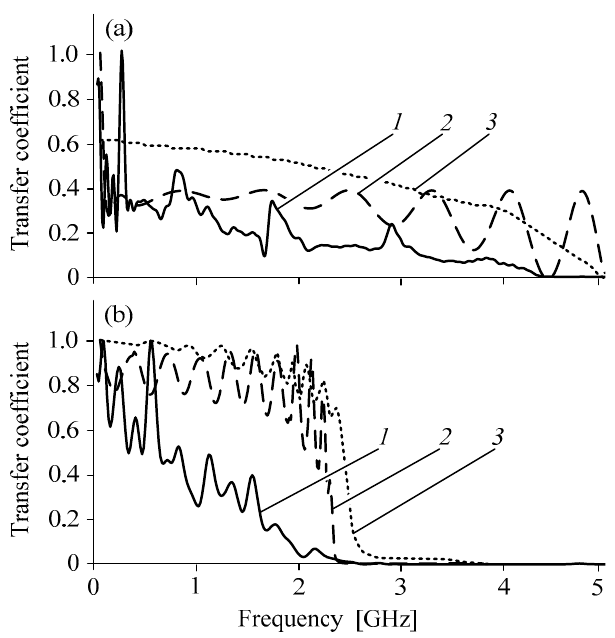
Figure 9. Modeling results and measurements of the hybrid meander systems at ( a ) 0 nH and ( b ) 10 nH, where 1 = measurements, 2 = CST Microwave Studio ® , and 3 = Sonnet ® .